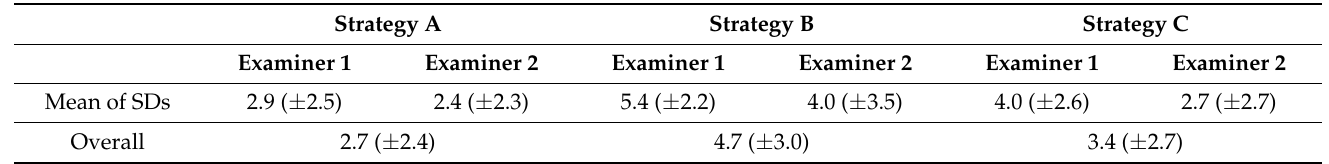
Table 6. Average scanning time (±standard deviation) for each scanning strategy.